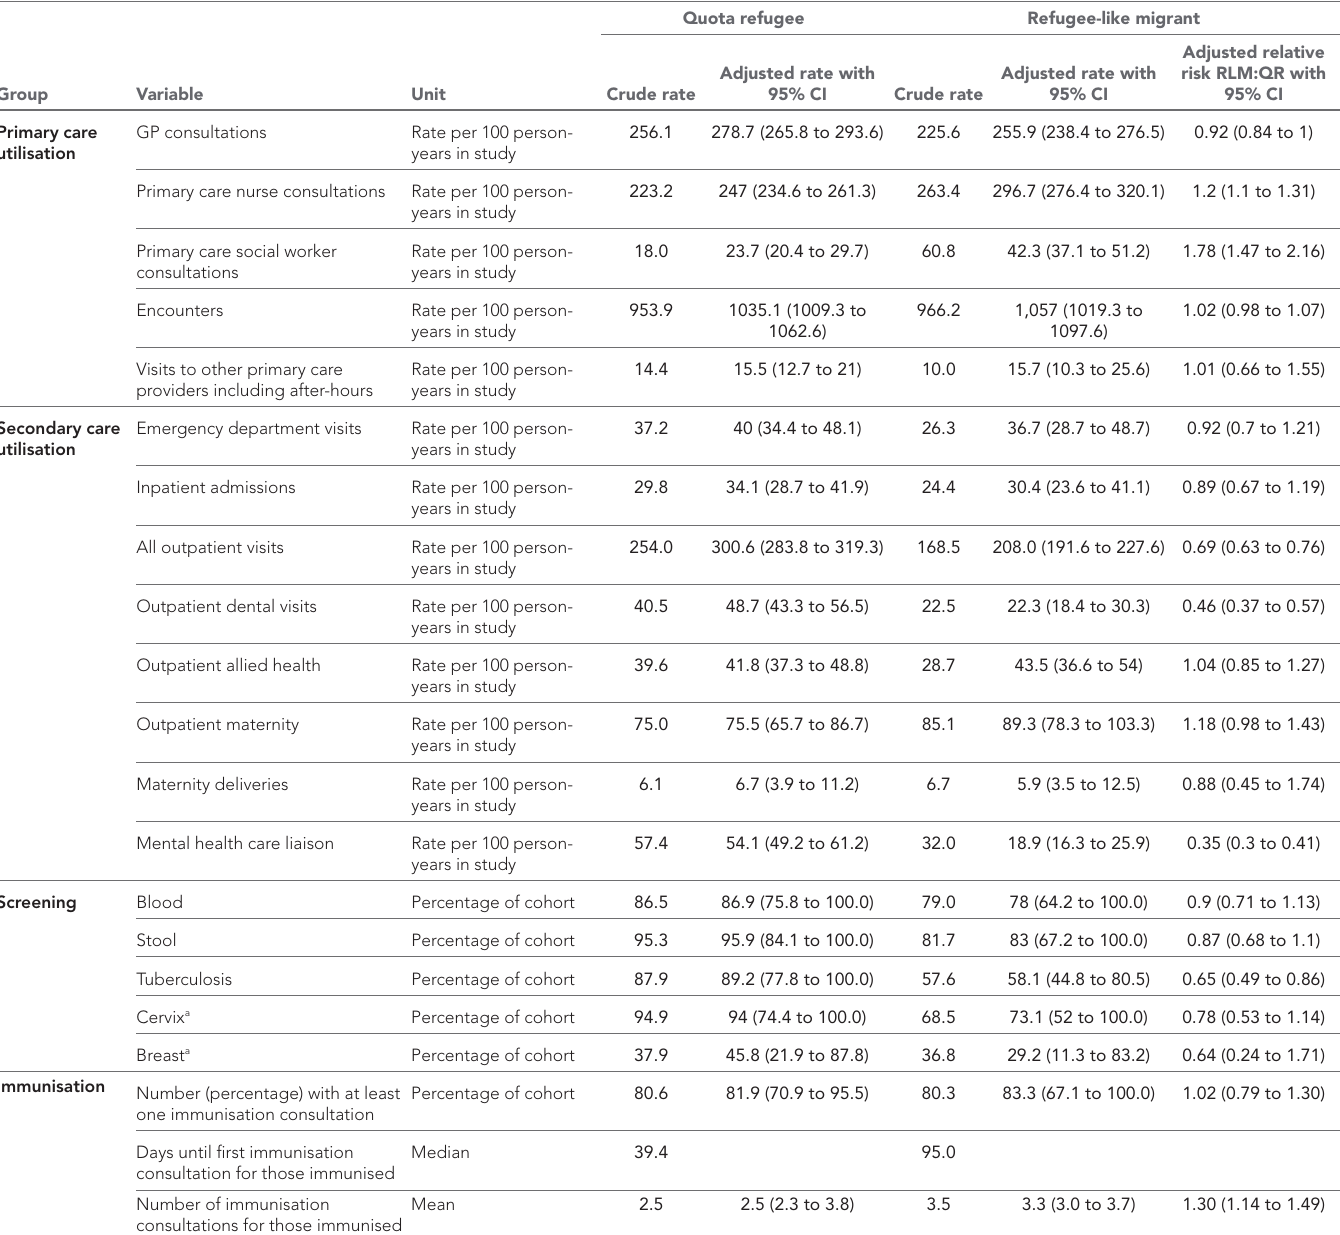
Table 3 Health utilisation, screening and immunisation by cohort adjusted for age and sex